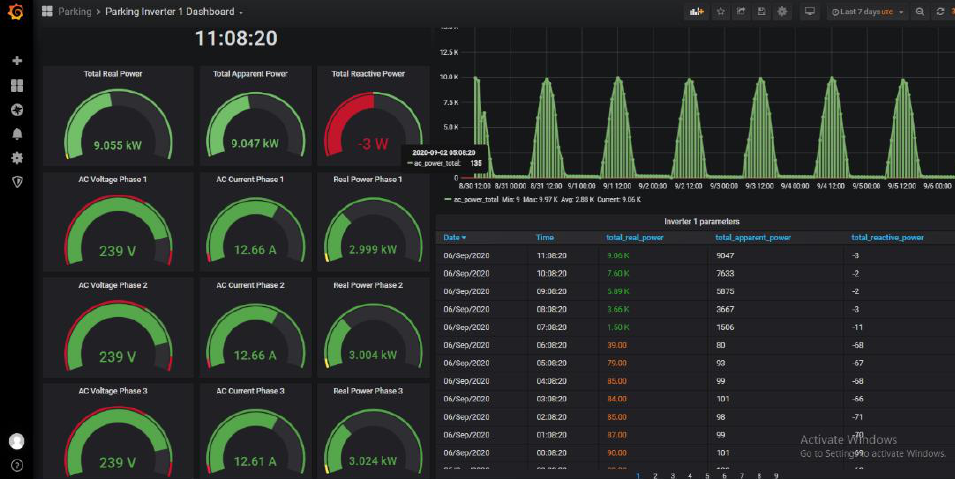
Figure 20. A Grafana dashboard that shows the parameters queried from the Solar Car Park DER.